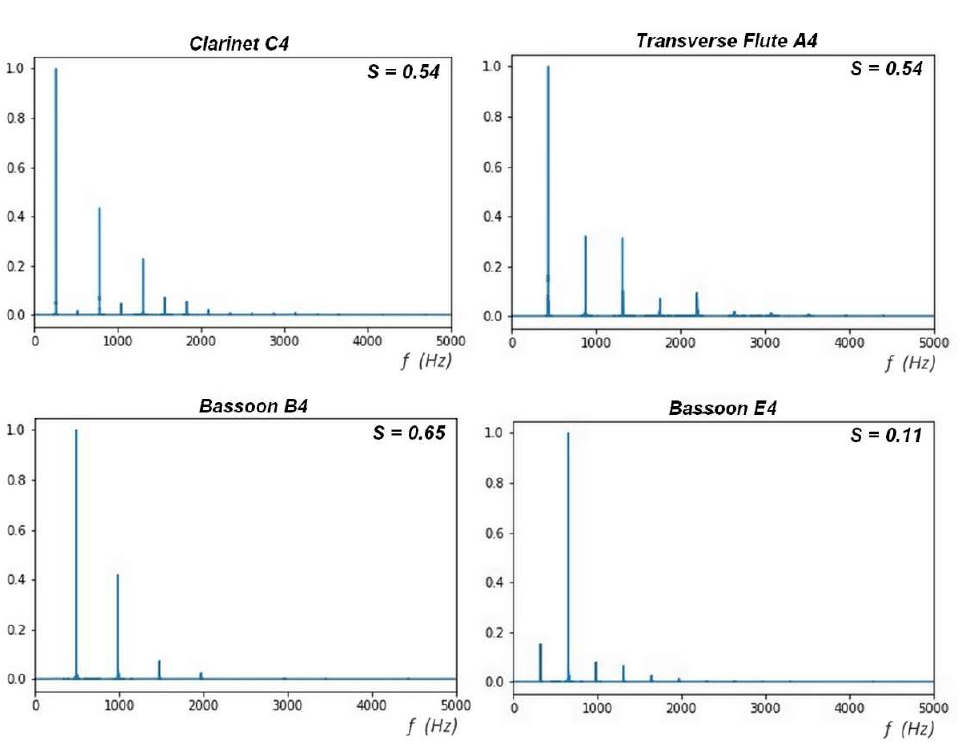
Figure 5. Example of Timbral Coefficient S . Above: The spectra of the Clarinet for C#4 and of the Transverse Flute for A4 show the same Sharpness S = 0.54. Bottom: Bassoon spectra in B4 and E4, with coefficients of S = 0.65 and S = 0.11 respectively.